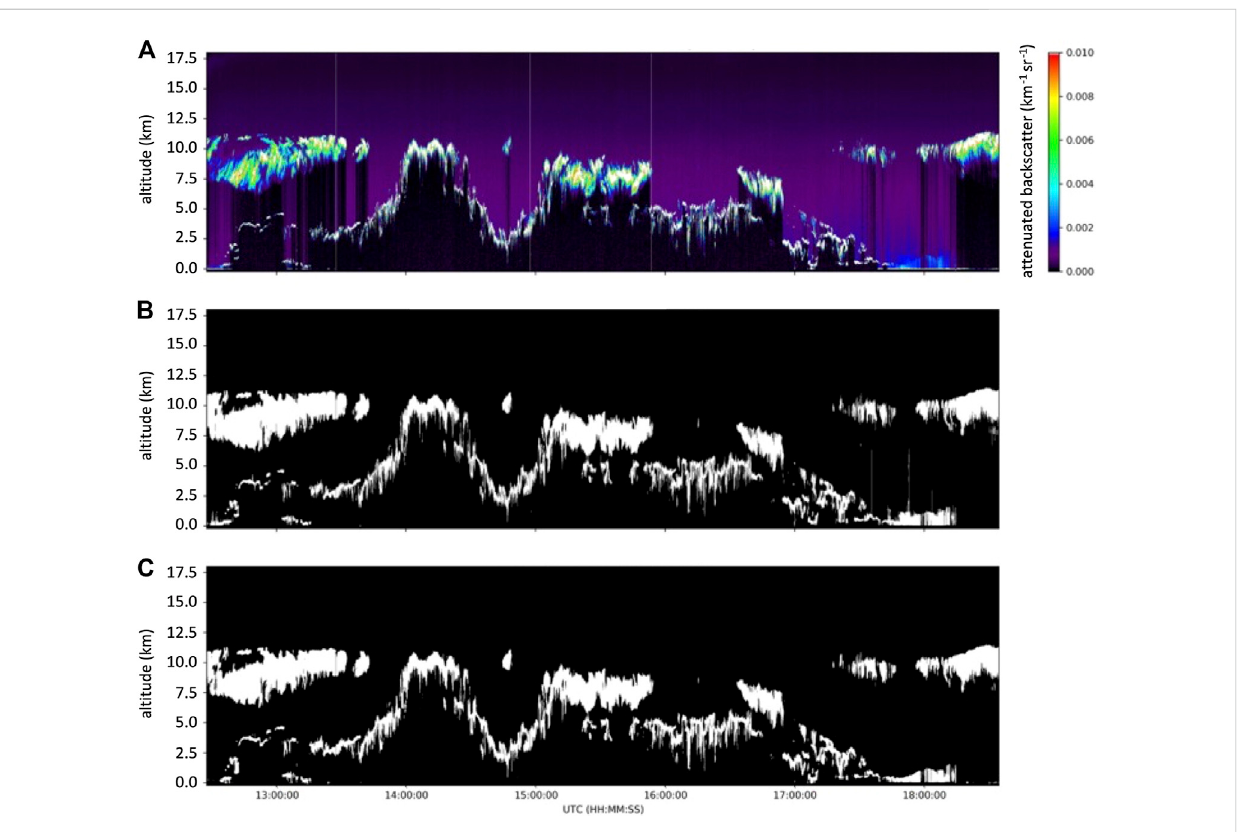
Table 1. Prior CPL data was used as training data (all CPL data